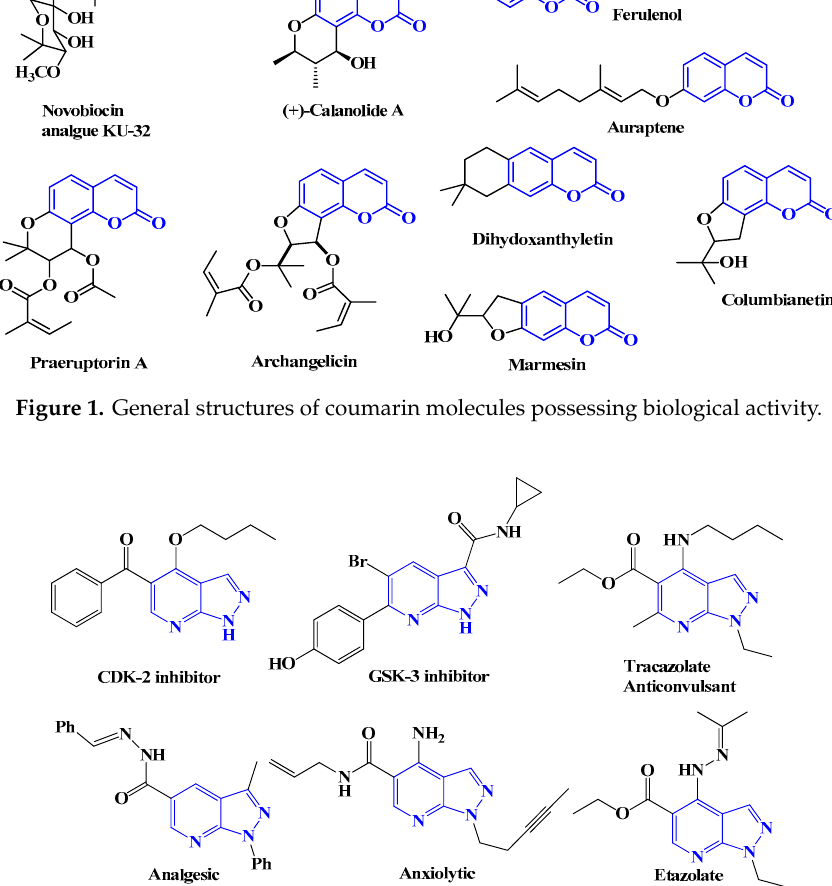
Figure 2. Biologically active compounds having pyrazolo[3,4- b ]pyridine unit.